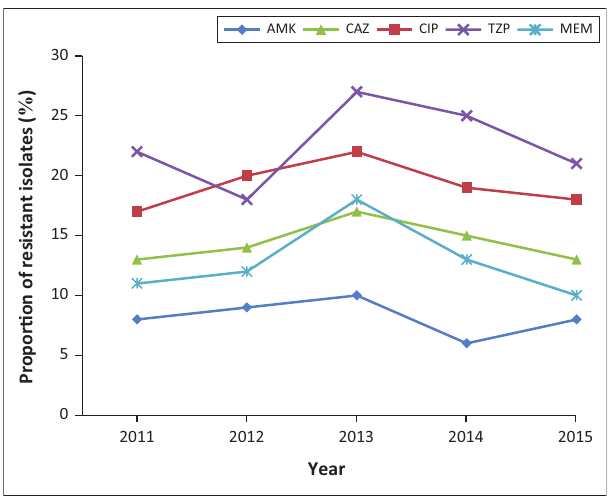
FIGURE 4: Resistance profile of S. aureus in the ESKAPE group